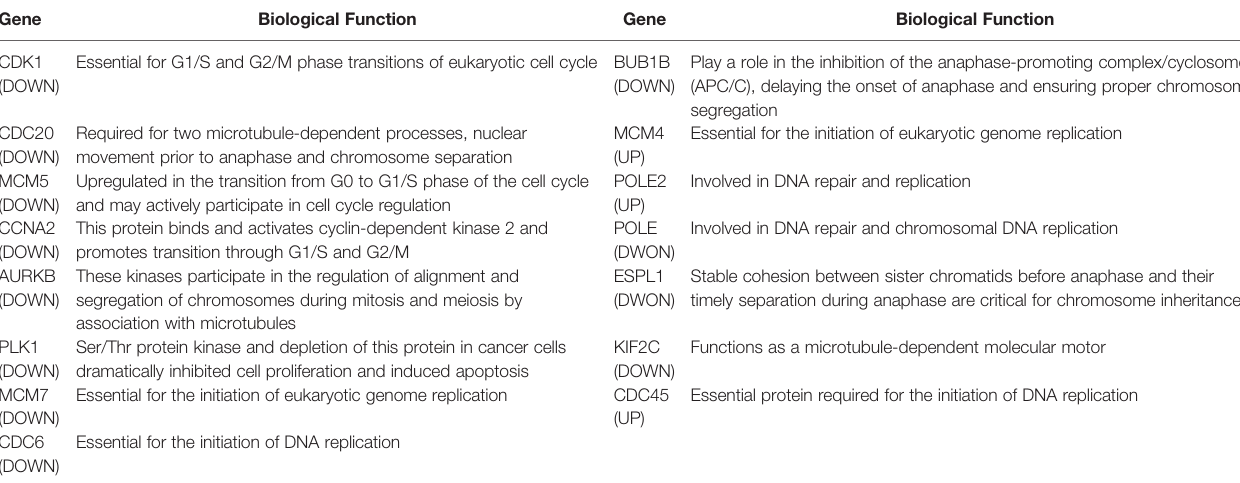
TABLE 1 | Biological functions of hub genes in cell cycle-related gene network. Gene Biological